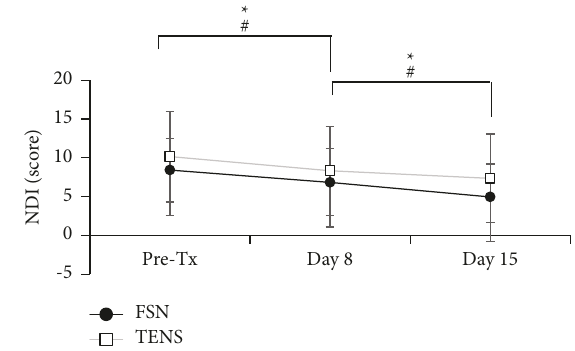
Figure 8: Comparison of the short-term and long-term effects on NDI. The score of NDI was measured on day 1 pre-treatment and followed up to day 8 and day 15 in both groups. Asterisks ( ∗ ) and hashtag ( # ) showed the P < 0 . 05 in FSN or TENS group, respectively. FSN: Fu’s subcutaneous needling, TENS: trans- cutaneous electrical nerve stimulation; NDI: neck disability